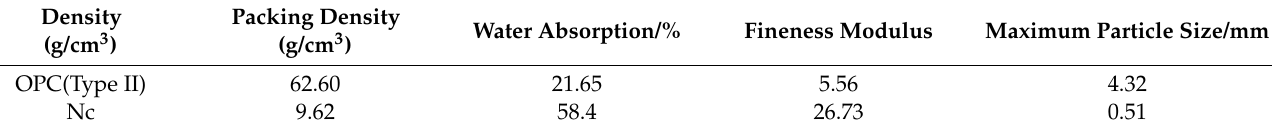
Table 2. Technical specifications of sand.